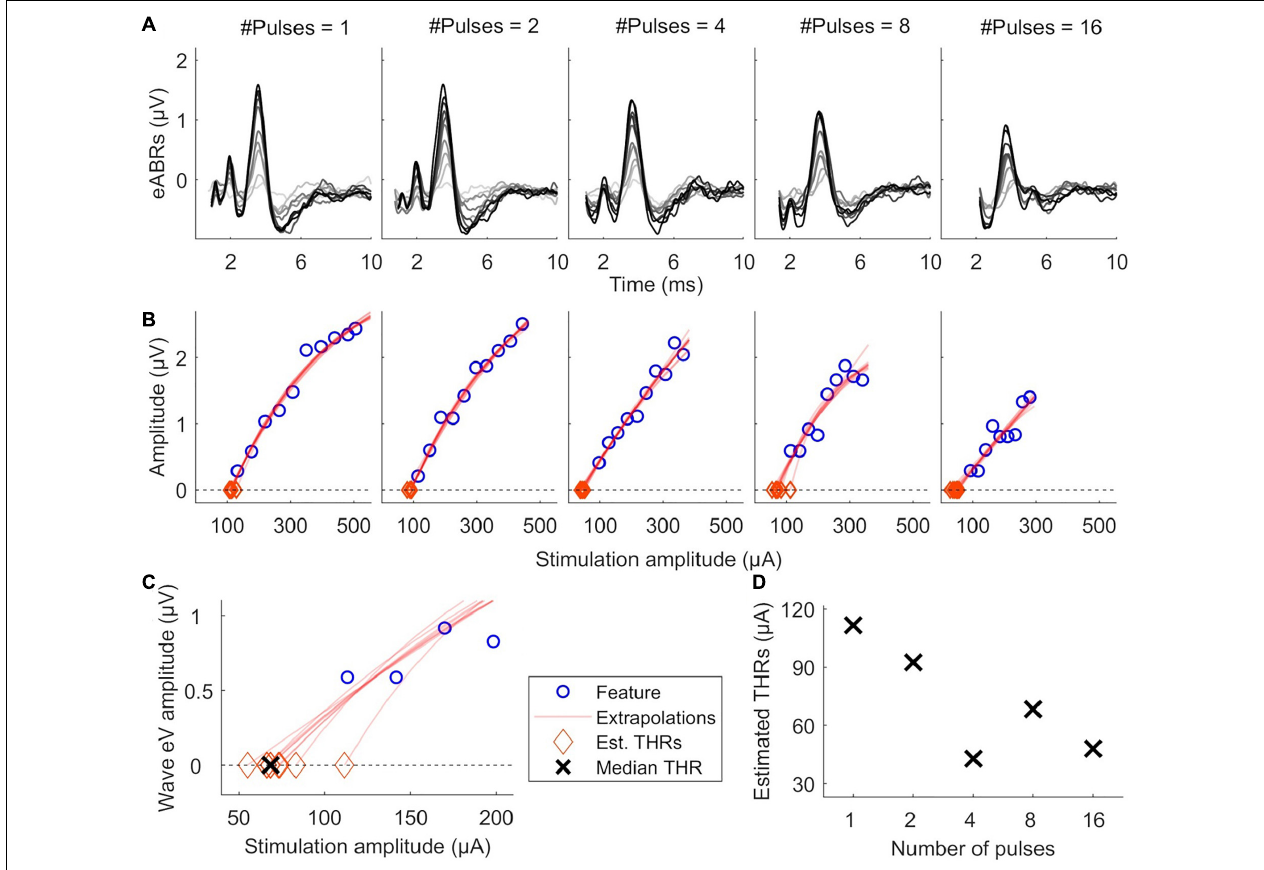
FIGURE 2 | Illustration of eABR threshold (THR) estimation for subject S8L. (A) valid eABRs in each MP condition. In each panel, eABRs to different stimulation amplitudes are plotted. (B) corresponding growth functions (blue circles) in panel (A) , growth function fittings (red lines) and eABR THR estimations (red diamonds). (C) Details of eABR estimation from B (8-pulses condition). The “ × ” shows the median of estimated eABR THRs (diamonds). (D) Estimated eABR THRs as a function of number of pulses.